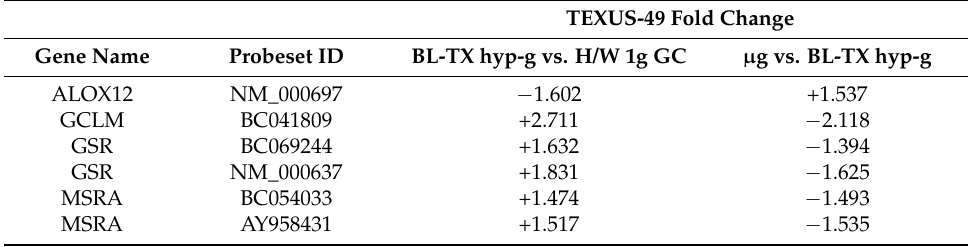
Table 7. Differentially regulated transcripts identified for the TEXUS-49 suborbital ballistic rocket campaign data sets. All 17 transcripts were reversely regulated with respect to microgravity and hypergravity conditions. Plus: significantly up-regulated transcripts ( p -value < 0.05, fold change (FC) ≥ +1.3), minus: significantly down-regulated transcripts ( p -value < 0.05, FC ≤ − 1.3). FCs are ratios between the averages of linear expression values. If the ratio is <1, FC is calculated as the negative reciprocal of the ratio. For the abbreviations of the experiment group names see Table